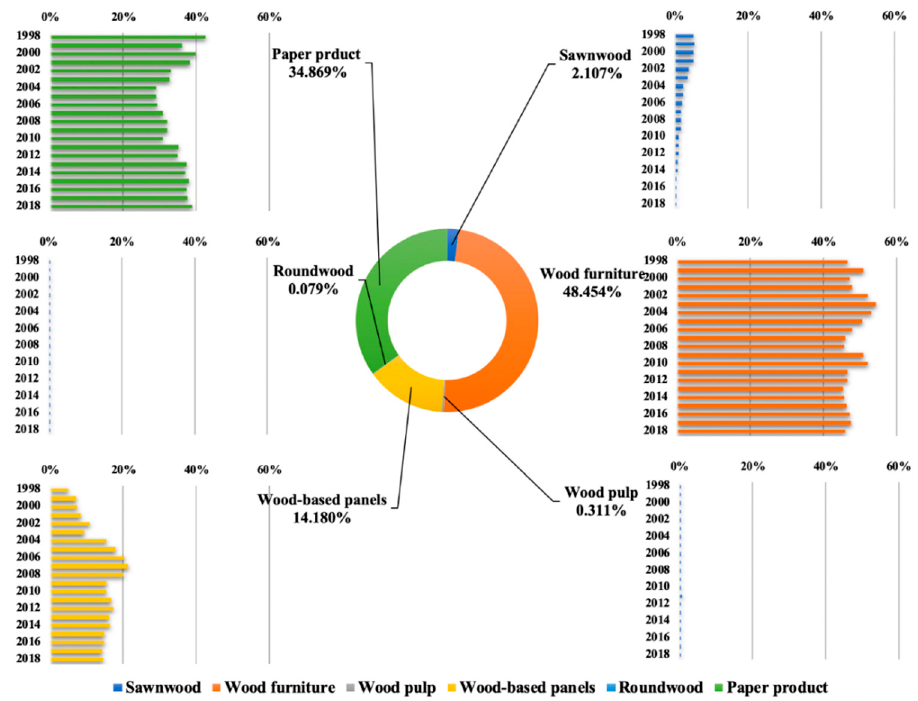
Figure 1. The proportion of the export value of wood forest products of China. Source: calculated according to the data of the United Nations UNCOMTRADE database (the percentage of the pie chart in the middle of Figure 1 represents an average export percentage between 1998 to 2018).